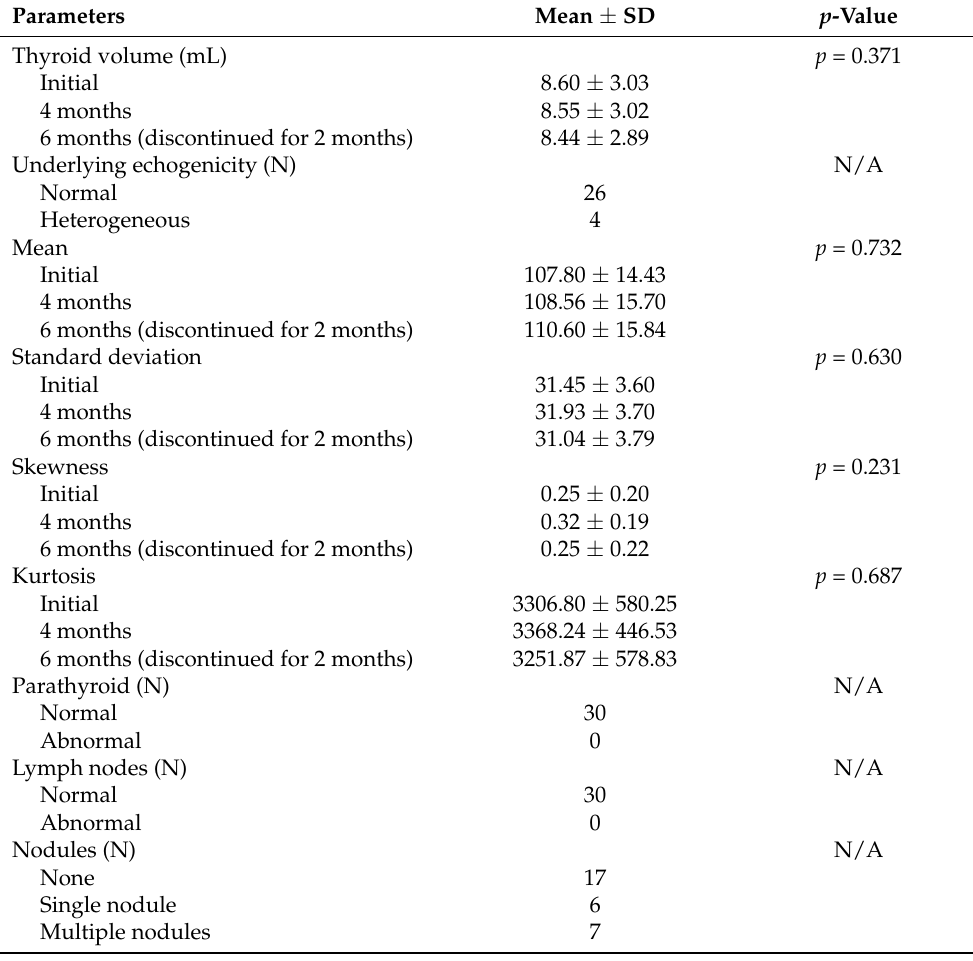
Table 1. Changes in sonographic findings during the